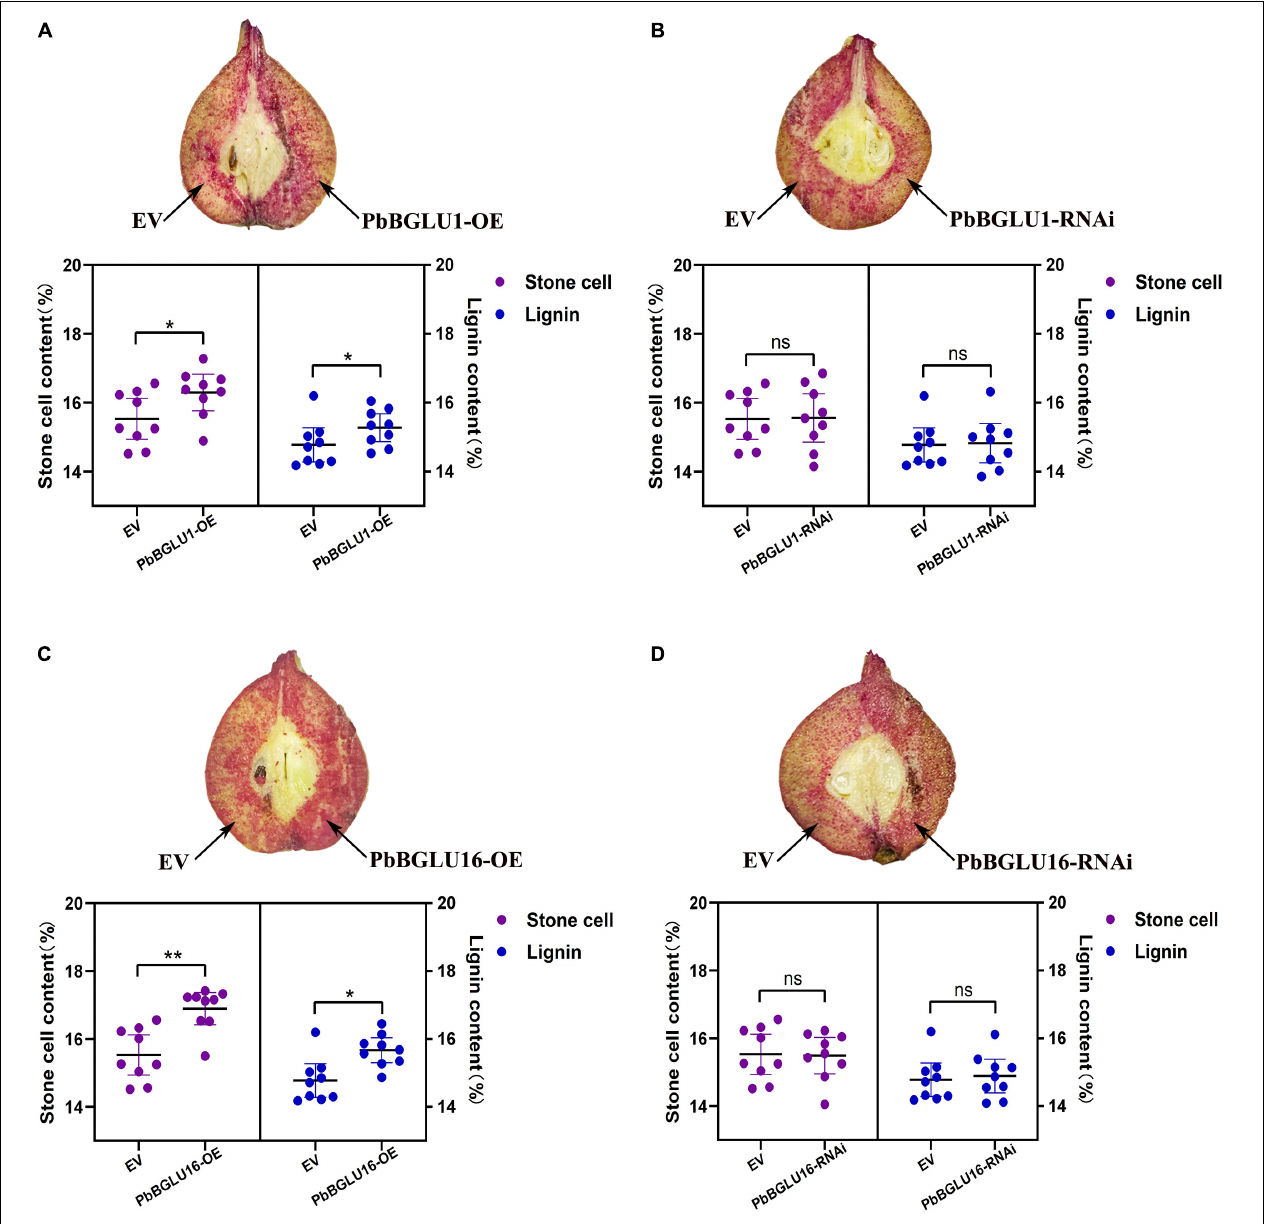
FIGURE 8 | Transient assays using PbBGLU1 and PbBGLU16 silencing and overexpression constructs in “Dangshansuli” fruit at 39 days after flowering (DAF). Images were taken at 10 days after agro-infiltration. Cross-sections of PhBGLU1, PbBGL.U16 overexpression (A,C) and silencing (B,D) pear fruits were stained with phloroglucinol–HCI. Lignin and stone cell contents in PbBGLU1, PbBGLU16 overexpression (A,C) and silencing (B,D) flesh tissue around the infiltration sites, more than three fruits were injected with each construct in an experiment that was repeated three times. EV, empty vector; (* P < 0.05, ** P <